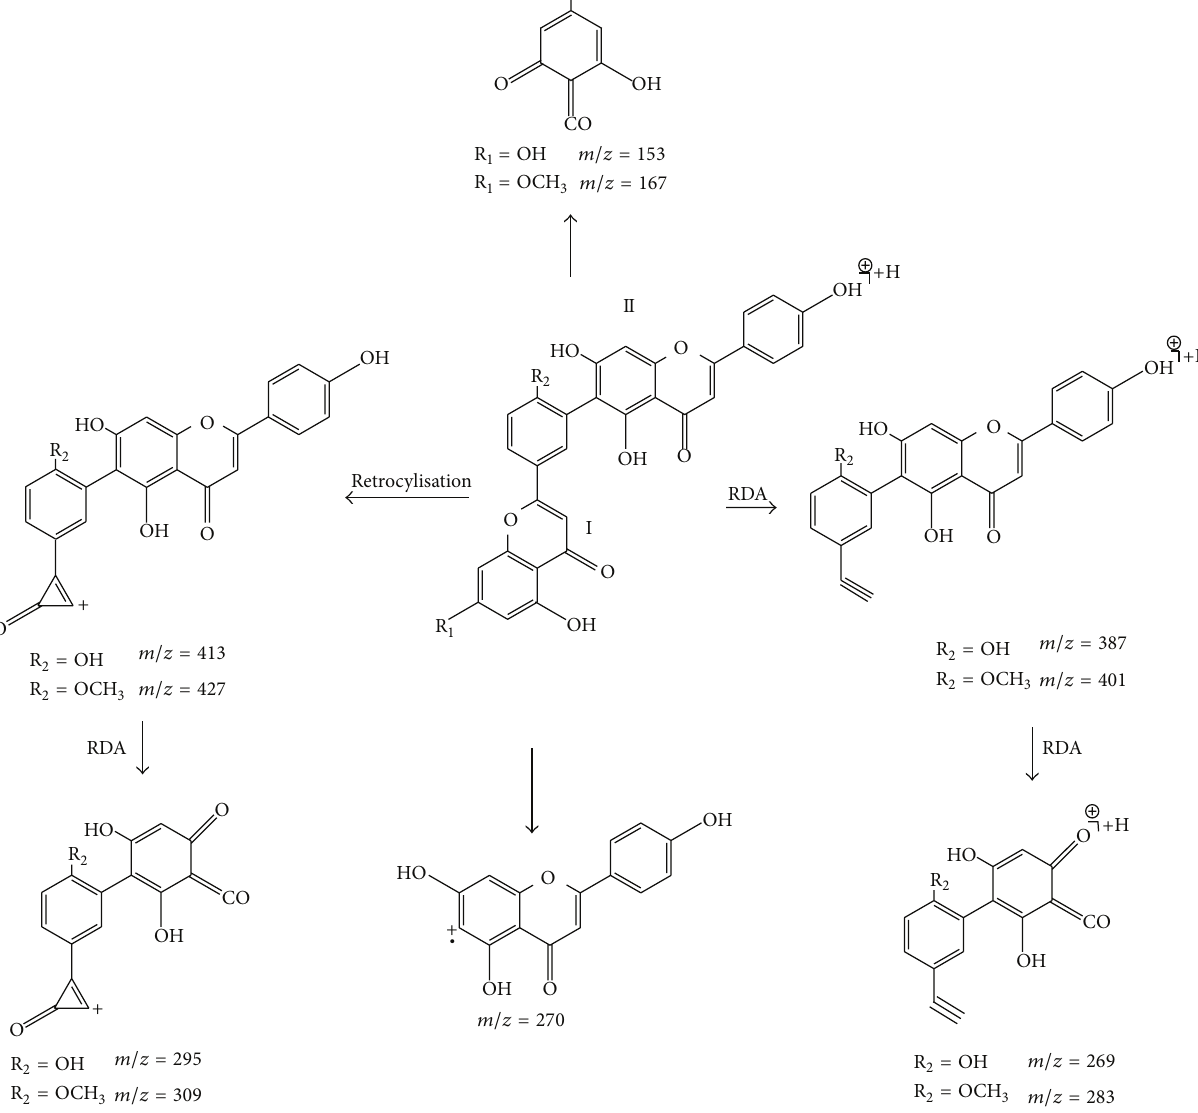
major fragmentation of the hinokiflavone-type biflavonoids shows great difference with the first two types of biflavonoids, because two flavonoid parts of the hinokiflavone type are not a C-C bond but a C-O